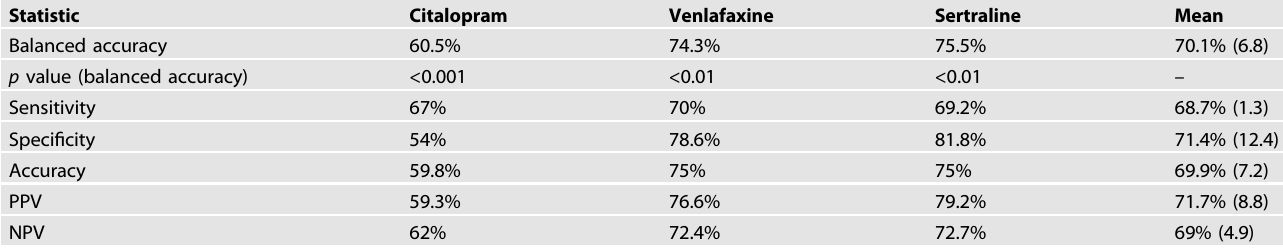
Table 1. Algorithm test statistics.